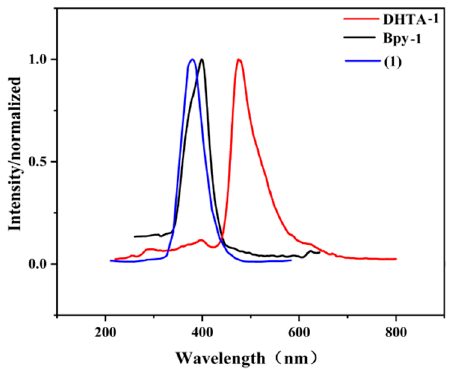
Figure 4. Solid-state emission spectrum of the complex, DHTA (2,5-dihydroxy-1,4-terephthalic acid) and Bpy (2,2 ′ -bipyridine) at room temperature.